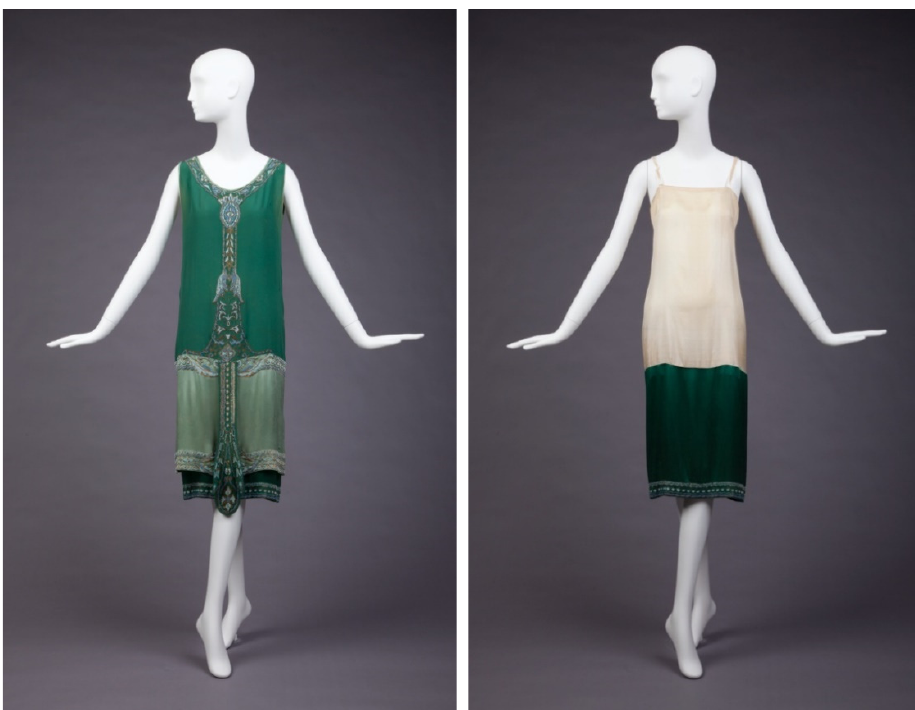
Figure 1. Callot Soeurs dress, 1925, Goldstein Museum of Design (1990.003.005a-b). The two-part garment is composed of an overdress of green satin with beading at neck, center front, hipline, and hem and a slip dress, off-white with green border of beading around bottom. (From the Collection of the Goldstein Museum of Design, Gift of Mrs. Roger (Katherine) Shepard).